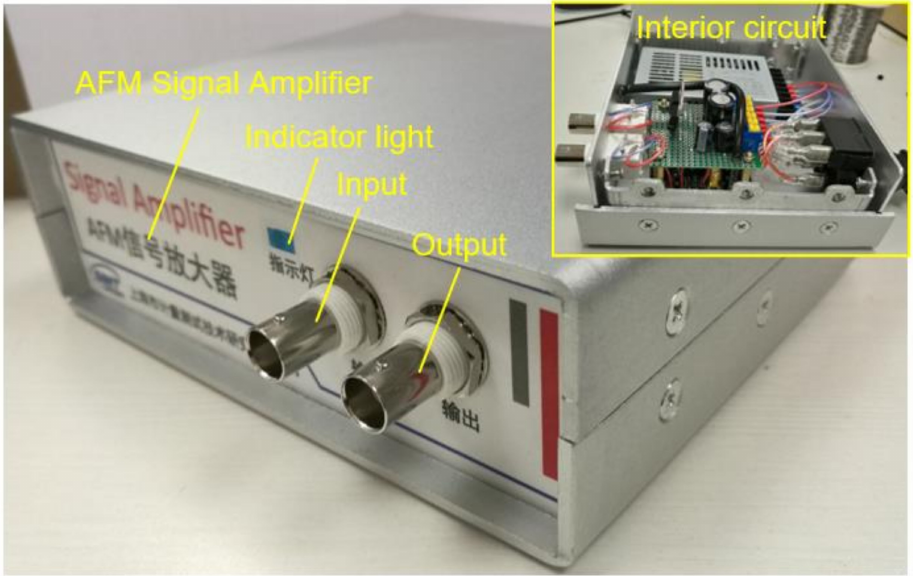
Figure 5. The AFM signal